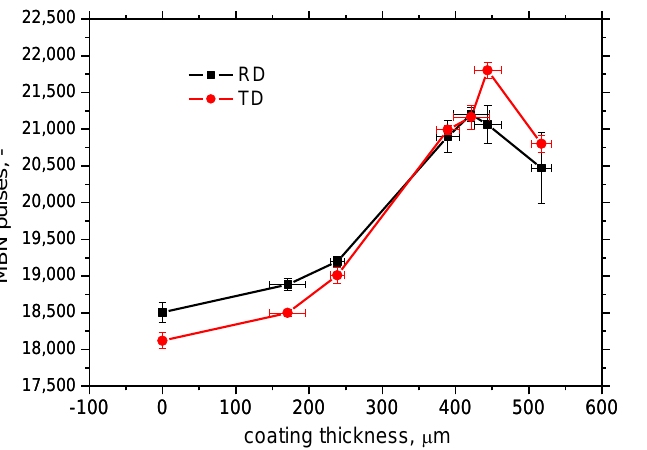
Figure 9. MBN pulses height distribution. ( a ) RD and ( b ) TD.